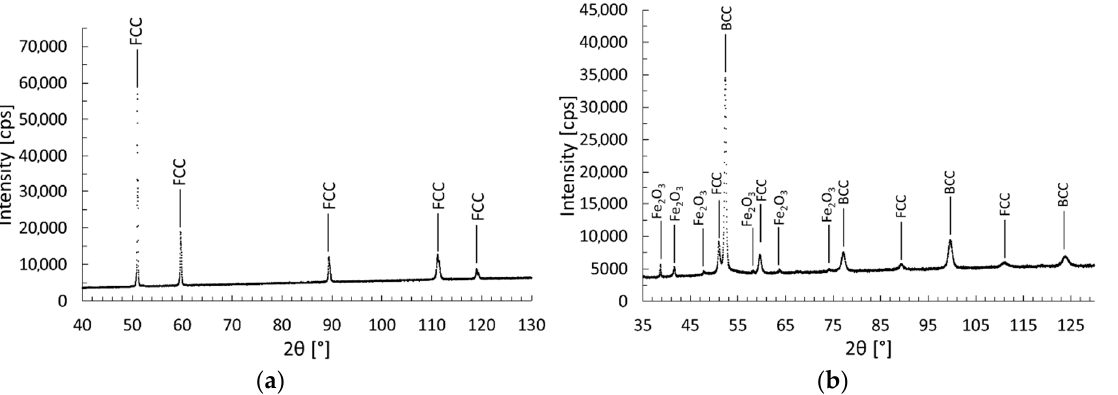
Figure 13. XRD of ( a ) Sample2 (CL20ES) and ( b ) Sample5 (CL50WS). Finally, the samples were sandblasted with corundum powder (Al 2 O 3 ). The X-ray diffraction patterns (Figure 14) showed the phase composition of stainless and maraging steel. No iron oxide was identified. In the case of Sample3, very small traces of corundum contamination were identified. Quantitative analysis of the XRD pattern showed that for Sample6, the content of FCC and BCC phases are 17 wt% and 83 wt%, consequently. As with Sample5, there is a similar discrepancy between the XRD and Mössbauer data. The extension of the lines in both X-ray diffraction patterns is evident on sandblasted samples. This is probably related to the mechanical damage of the crystals on the surface of the samples by sandblasting.